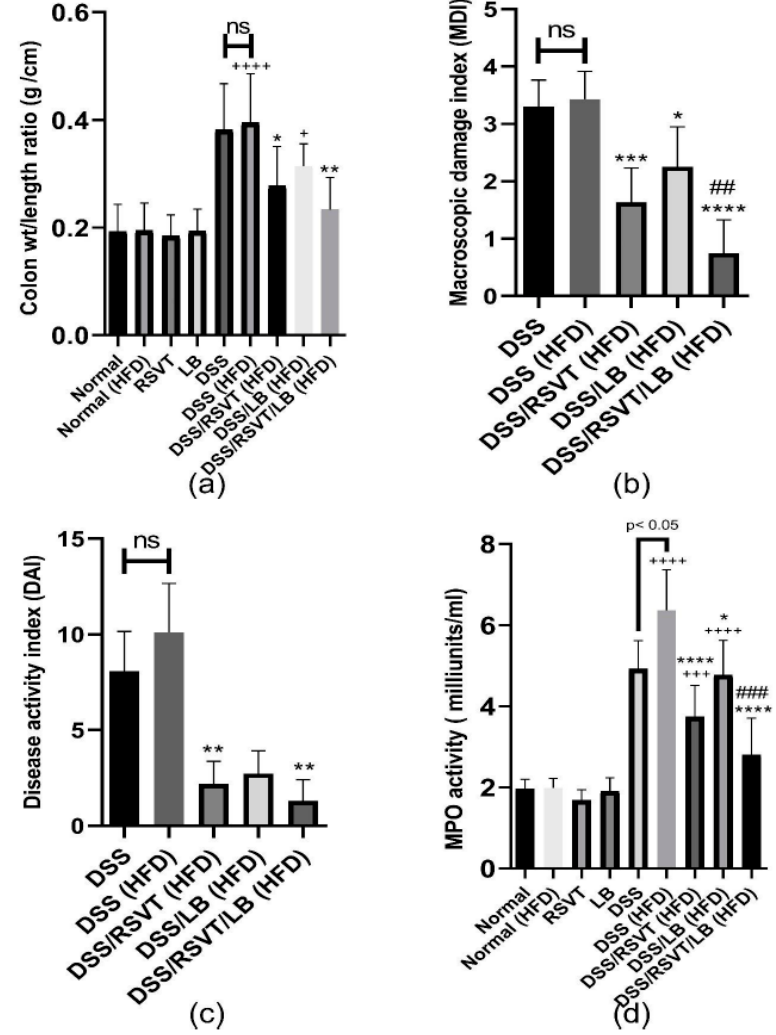
Figure 1. Effect of rosuvastatin (RSVT), Lactobacillus (LB), and their combined therapy on ( a ), colon weight/length ratio; ( b ), macroscopic damage index (MDI); ( c ), disease activity index (DAI); ( d ), myeloperoxidase (MPO) activity. +, p < 0.05 vs Normal (HFD); +++, p < 0.001 vs. Normal (HFD); ++++, p < 0.0001 vs. Normal (HFD); *, p < 0.05 vs DSS (HFD); **, p < 0.01 vs. DSS (HFD); ***, p < 0.001 vs. DSS (HFD); ****, p < 0.0001 vs DSS (HFD); ##, p < 0.01 vs. DSS/LB (HFD); ###, p < 0.001 vs. DSS/LB (HFD); ns, non-significant.